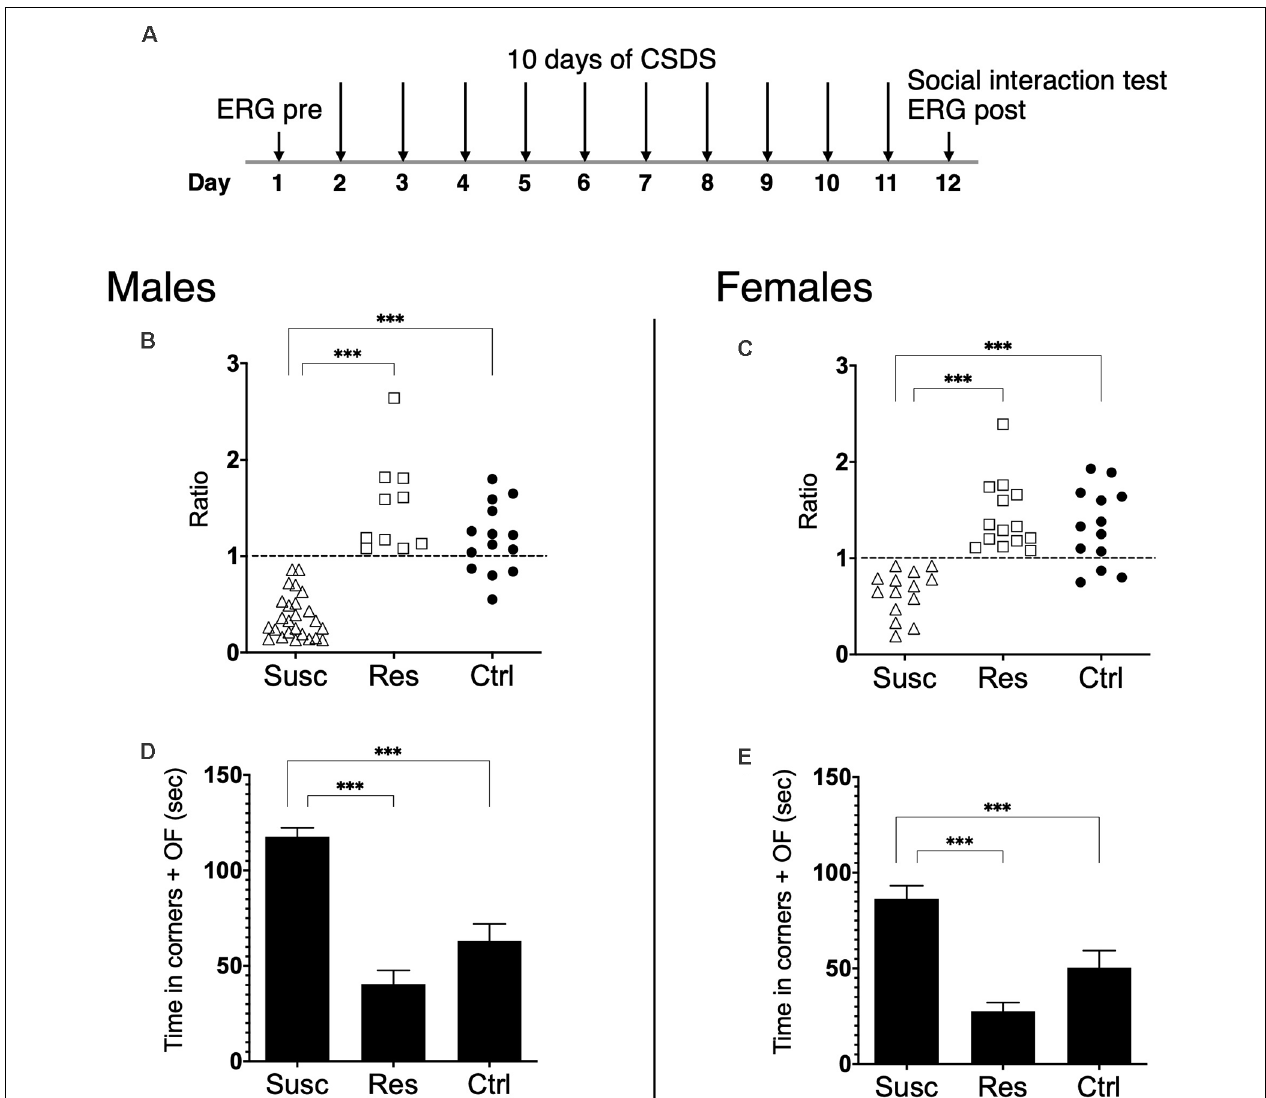
FIGURE 1 | (A) Schematic representation of the experimental timeline. Pre-stress ERG was assessed at day 1, followed by 10 days of CSDS 24 h after (day 2, ending day 11). The social interaction test and the post-stress ERG were assessed 24 h after the last defeat on day 12. (B,C) Susceptible, resilient, and control mice are divided according to their SI ratio score. Male (B) and female (C) mice susceptible to CSDS exhibit social avoidance (ratio < 1) when compared to male and female resilient and control mice. (D,E) Male (D) and female (E) susceptible mice spent significantly more time in the corners and the open field (OF) areas than the male and female resilient and control mice. Significance was determined using two-way ANOVA with Bonferroni multiple comparisons test. Symbols and bars represent the group average ± SEM; ∗∗∗ p < 0.001; n -values are given in the “Materials and Methods”